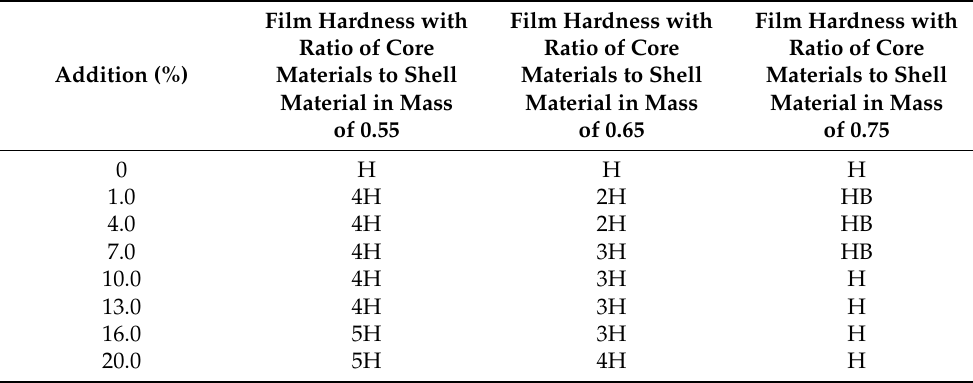
Table 3. Effect of microcapsule content on film